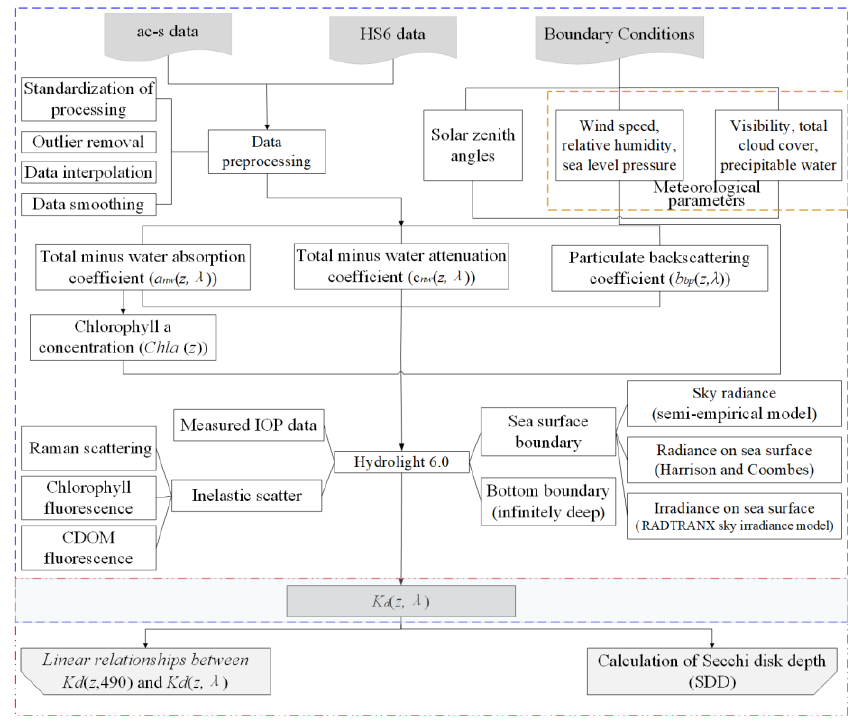
Figure 1. Flowchart of this study.